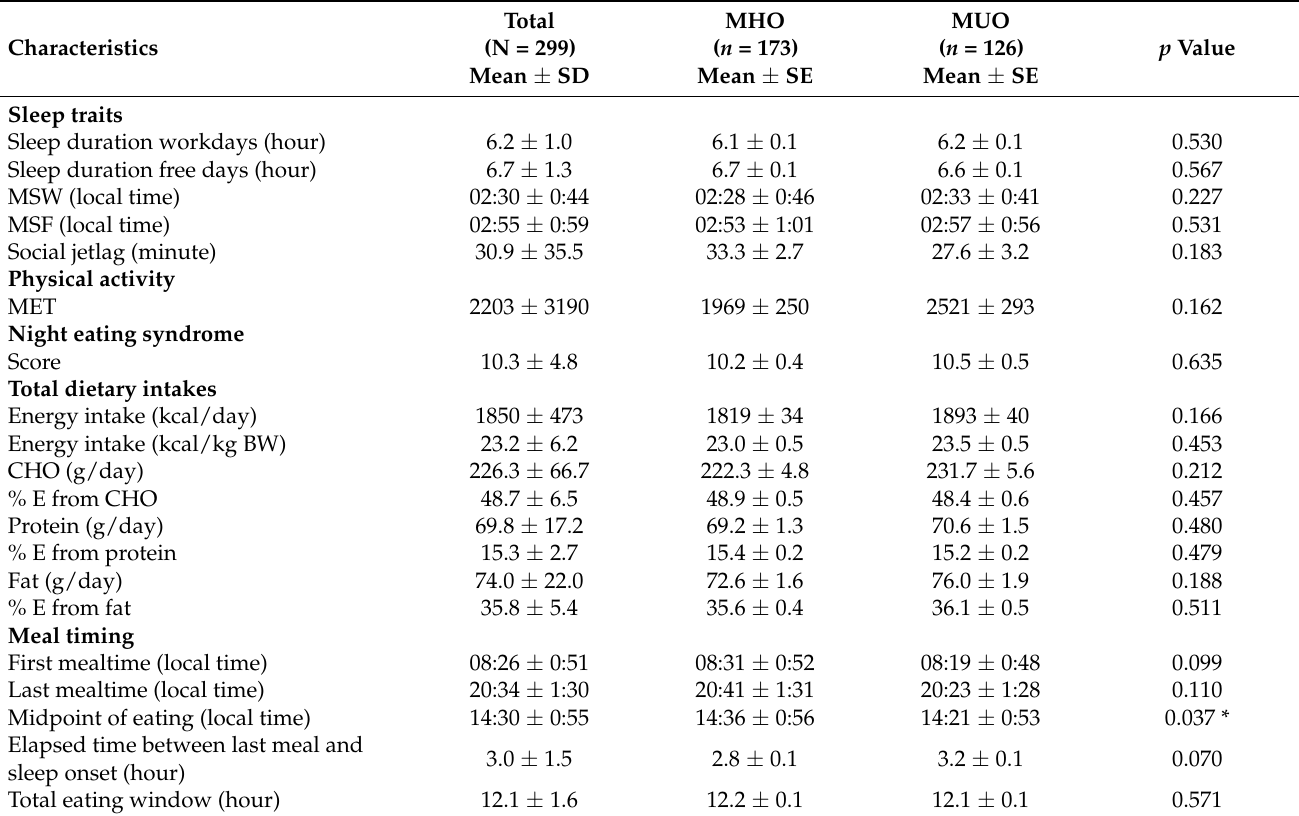
Table 2. Lifestyle characteristics and dietary intake of MHO and MUO.